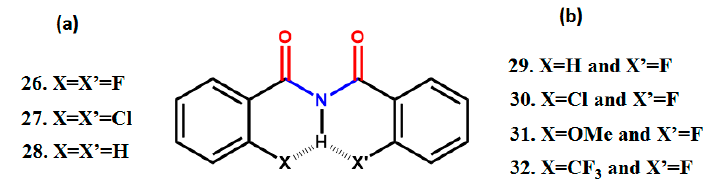
Figure 25. The chemical structures of the derivatives of 2-X- N -(2-X’-benzoyl)benzamide.